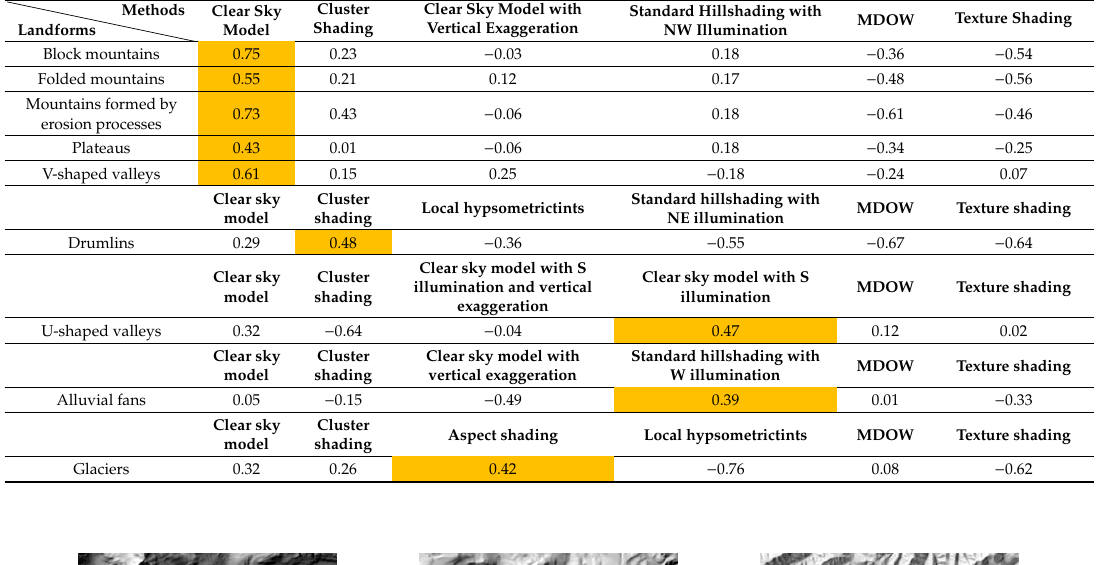
Table 2. Assessment indices per method and landform as fractions.